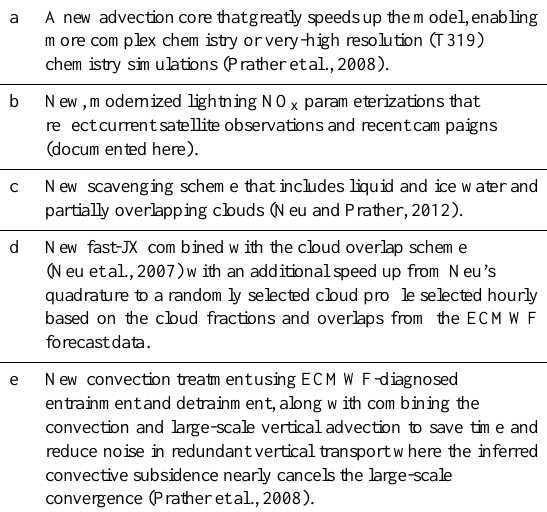
Table 1. The main model updates documented in this